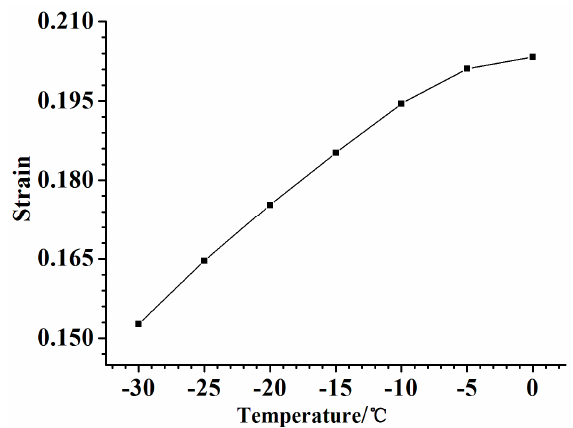
Figure 11. Failure stress - temperature curve.